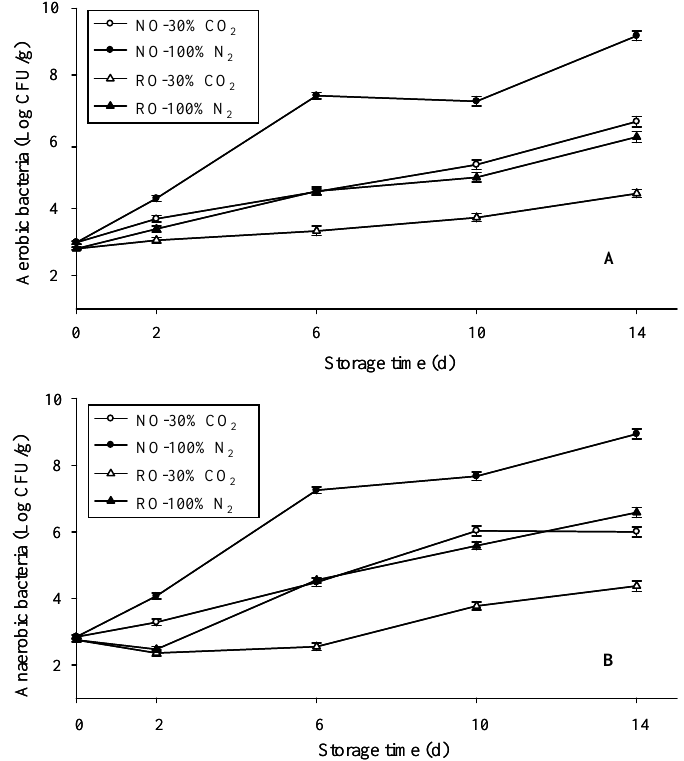
Figure 2. The effect of MAP and addition of rosemary extract, sodium acetate and calcium lactate mixture on aerobic bacterial counts (A) and anaerobic bacterial counts (B) (Log CFU/g unit; n = 12) of pre-cooked hamburger patties during refrigerated